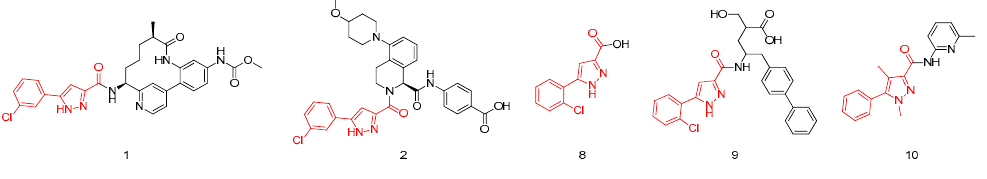
Figure 3. Representative pyrazole derivatives.